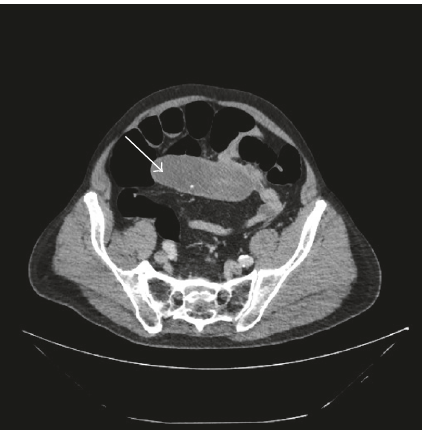
Figure 3: CT abdomen pelvis on admission showed a change in the morphology of the tubular cystic structure which was now vertical to transvers axis orientated with thickened walls and fat stranding suggestive of torsion or inflammation of the